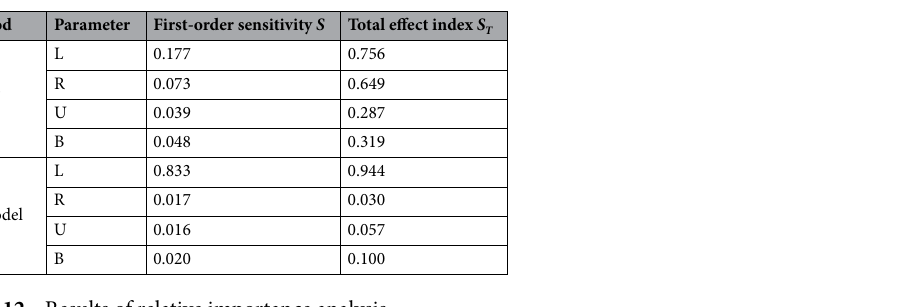
Table 12. Results of relative importance